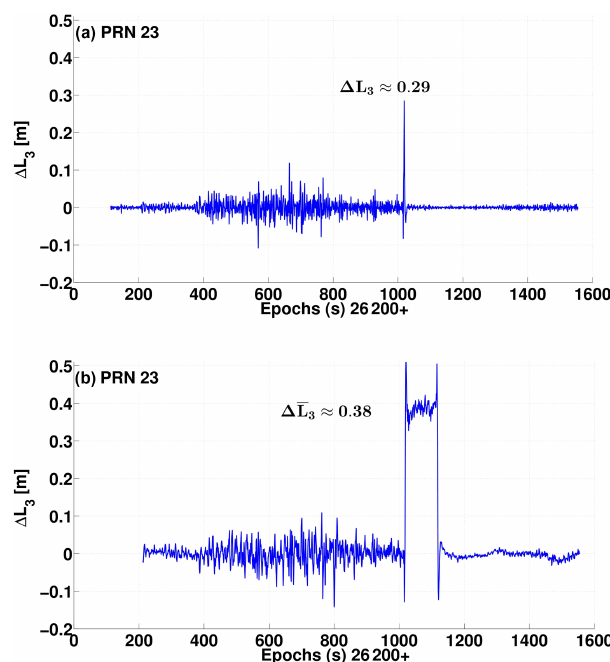
Figure 7. Illustration of the proposed cycle-slip detection approach based on an ionosphere-free linear combination from PRN23 of Swarm A on DoY 333, 2015. The following are shown: (a) (cid:49)L 3 between two successive epochs 0 . 29 = 0 . 4844 (cid:49)b 1 − 0 . 3775 (cid:49)b 2 and (b) (cid:49)L 3 between two epochs separated by 100 epochs 0 . 38 =